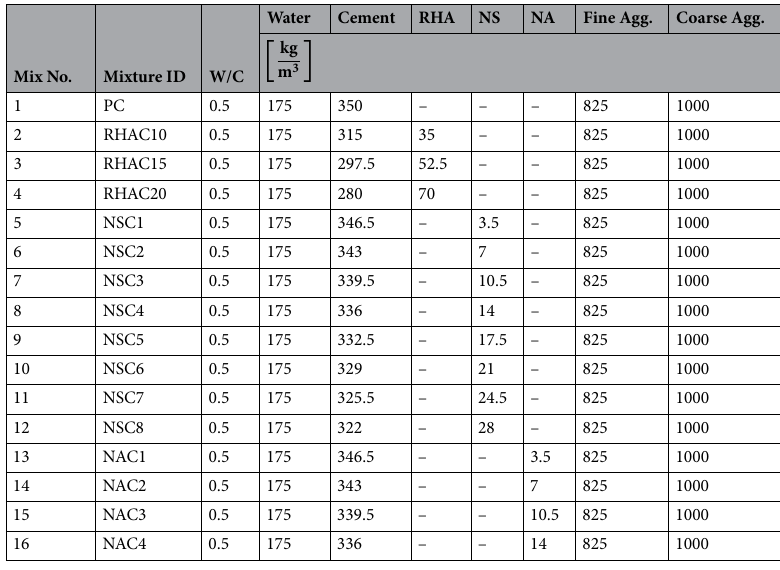
Table 6. Mix proportions of specimens.